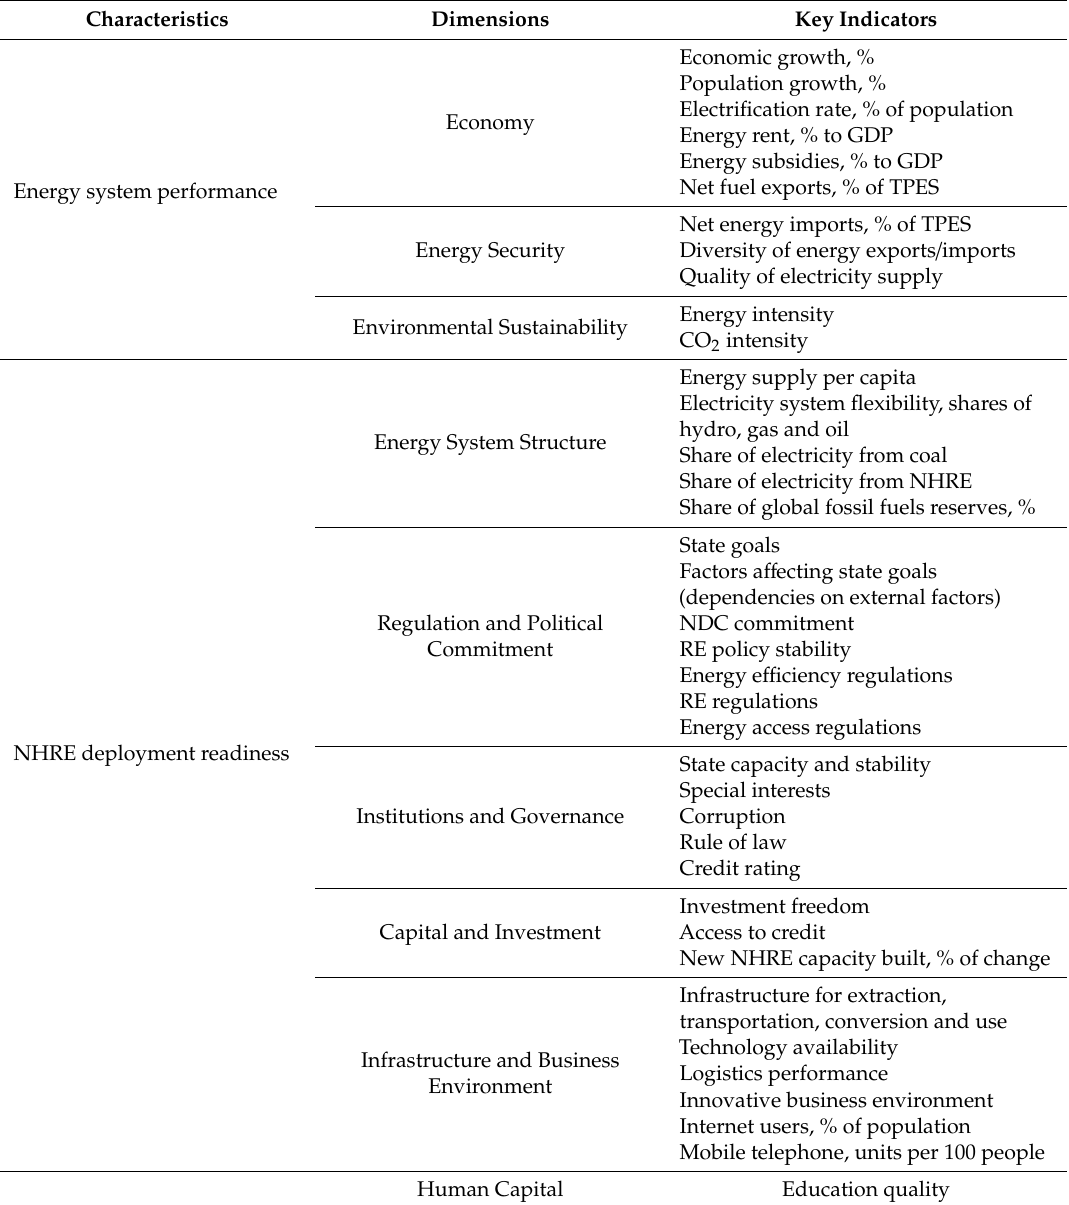
Table 1. Analytical Framework Energy System’s Performance—Deployment Readiness (Source: author, adapted from [77] (p. 31); [78]; [79] (pp. 185–187)).